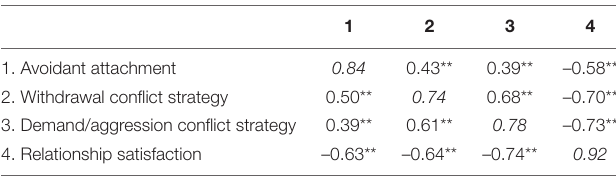
TABLE 3 | Correlations among target variables for men and women.